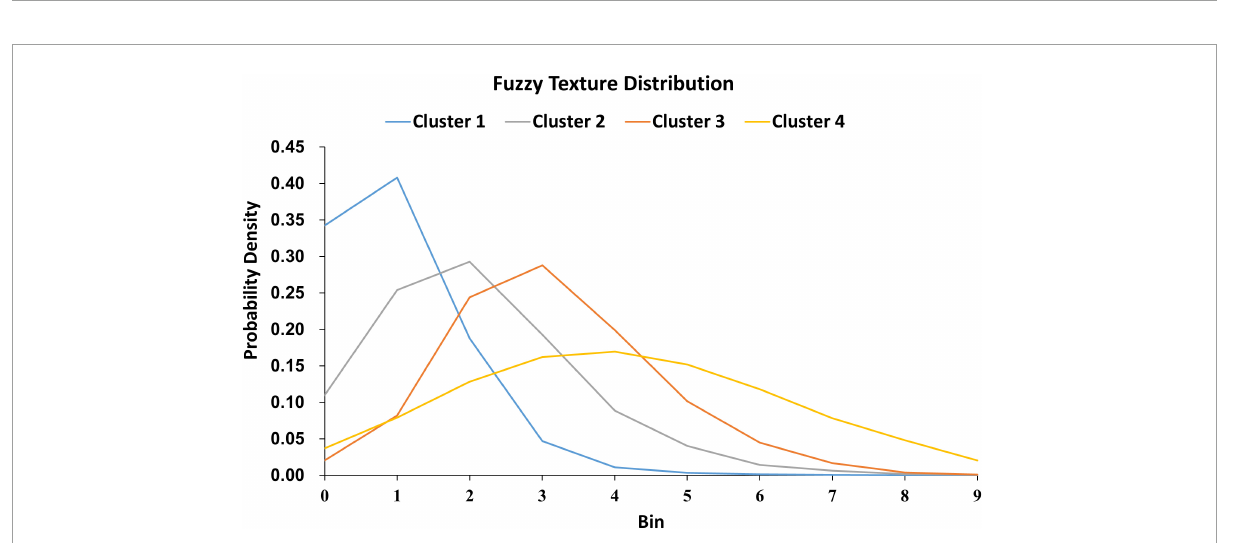
FIGURE9 The 280 WMH3D lesion images from the 32 subjects were classified into four clusters based on their fuzzy image textures. The label on the y-axis is the probabilities of voxels in the lesion assigned to the